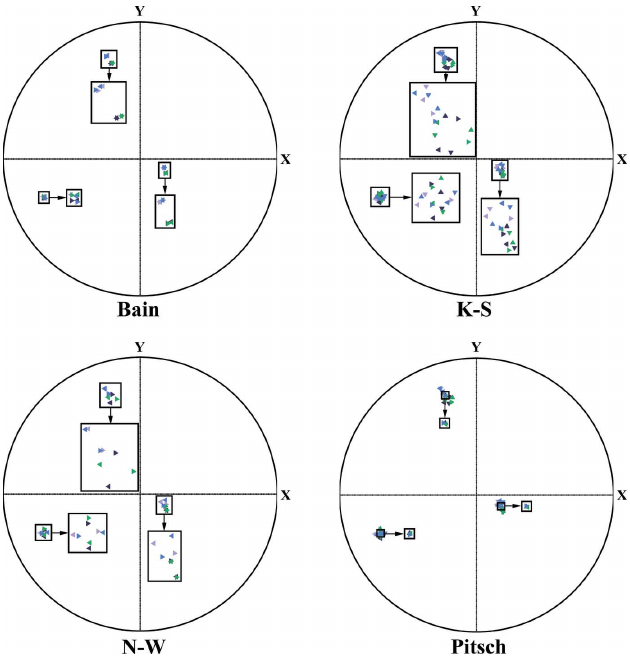
Figure 5 {001} A stereographic projections of austenite under the four ORs. Orientations obtained from different martensite variants are distin- guished with different colours that are consistent with those of the four variants in Fig. 2( a ): mauve for variant A , dark blue for variant B , green for variant C and blue for variant D . The non-equivalent austenite orientations obtained from one martensite variant are differentiated by the orientations of the triangular symbols. The clusters of poles in each stereographic projection are further magnified to give a convenient visualization of the positions of the